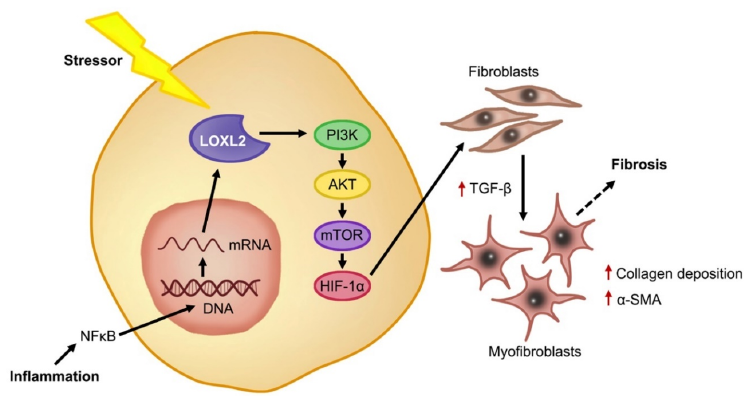
Figure 3. LOXL2-induced cardiac fibrosis. Under stress conditions such as inflammation, the activation of NFκB causes increased mRNA expression of LOXL2 and downstream, LOXL2 activates the PI3K/AKT/mTOR pathway, increasing TGF-β and triggering fibroblasts differentiation, where myofibroblasts secrete α-SMA and increase collagen deposition. Overstimulation of this process results in ECM deposition and fibrosis.